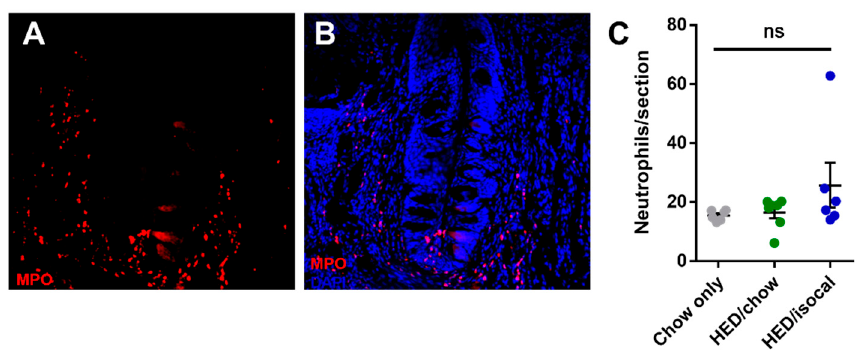
Figure 4. ( A ) Representative image of circumvallate papilla showing MPO staining (red). ( B ) Representative image of circumvallate papilla showing MPO staining (red), Dapi (blue) ( C ) MPO positive cells per CV trench for all treatment groups. Chow-only (grey, n = 6), high-energy diet (HED) then chow (green, n = 7), and HED then HED isocaloric (blue, n = 6). Bars represent means plus/minus SEM. Overall p = 0.141. ns denotes non significant.